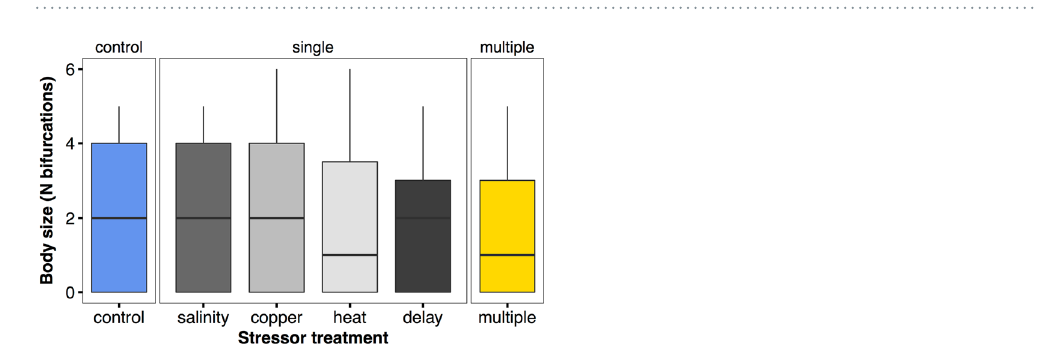
Figure 2. Comparison of control (blue), single stressor (grey), and multiple stressor (yellow) effects on colony size, measured as the number of bifurcations. Boxplots from raw data, treatment effects on x-axis, colony size on y-axis.